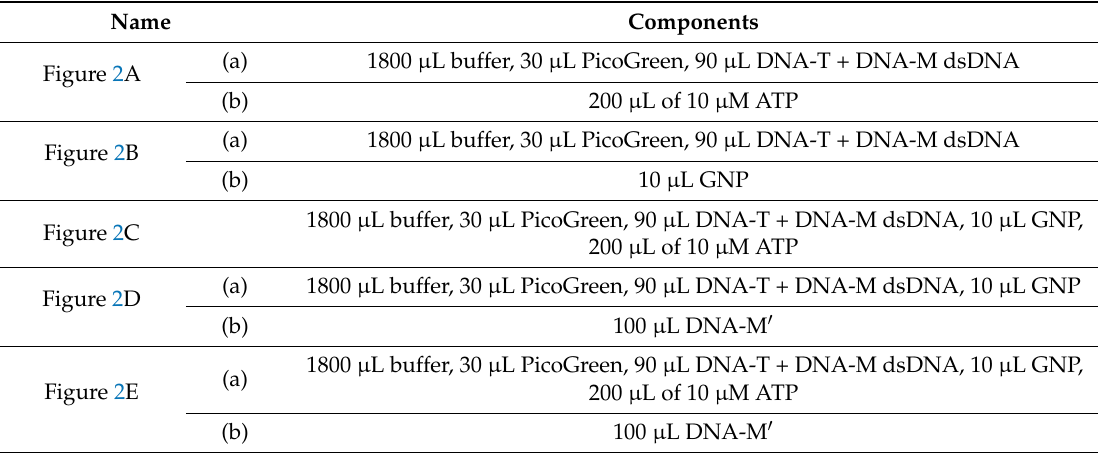
Table 5. Components in the experiment of Figure